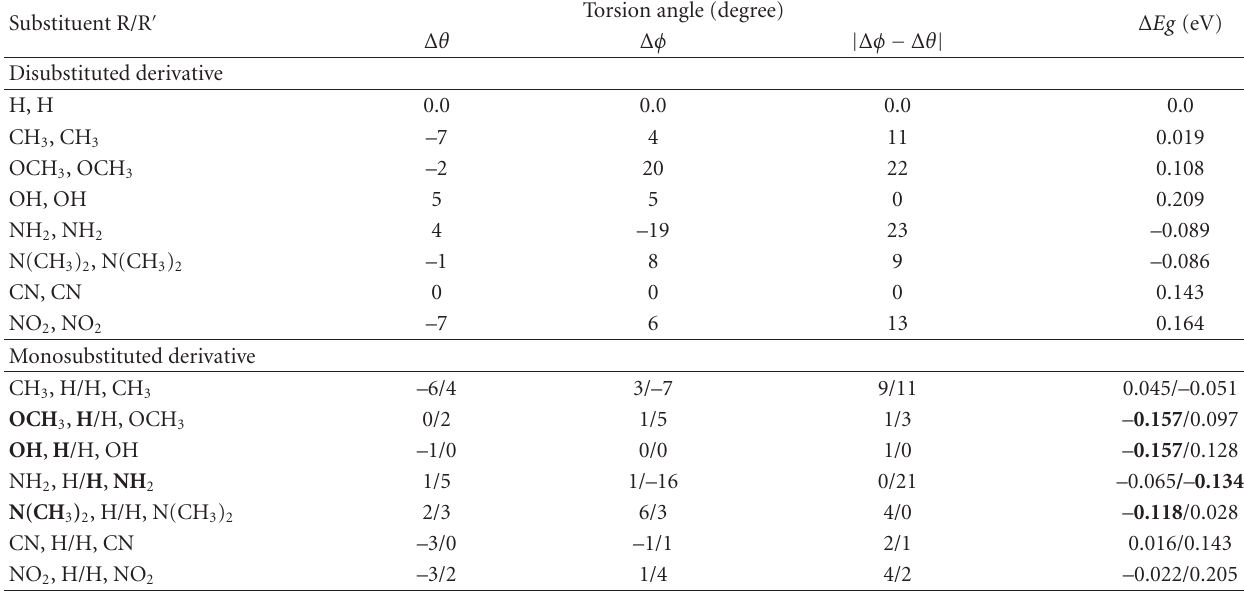
Table 2: Changes of the torsion angles ( Δ θ and Δ φ , defined in Figure 2), and the corresponding energy gap ( Δ Eg ), of the PTP derivatives obtained from the B3LYP/6–31G(d) calculations, relative to those of the PTP compound (R = R (cid:2) = –H), after subtraction of the values obtained from the PTP compounds by those of its